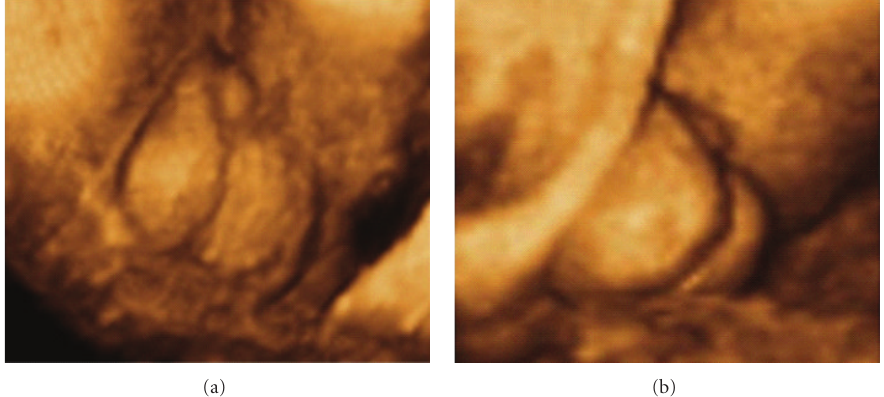
Figure 2: (a) and (b) Penoscrotal hypospadia assessed by three-dimensional ultrasonography in rendering mode, at 33 weeks of pregnancy, with short penis and with evidence of testicles inside a bifid scrotum.